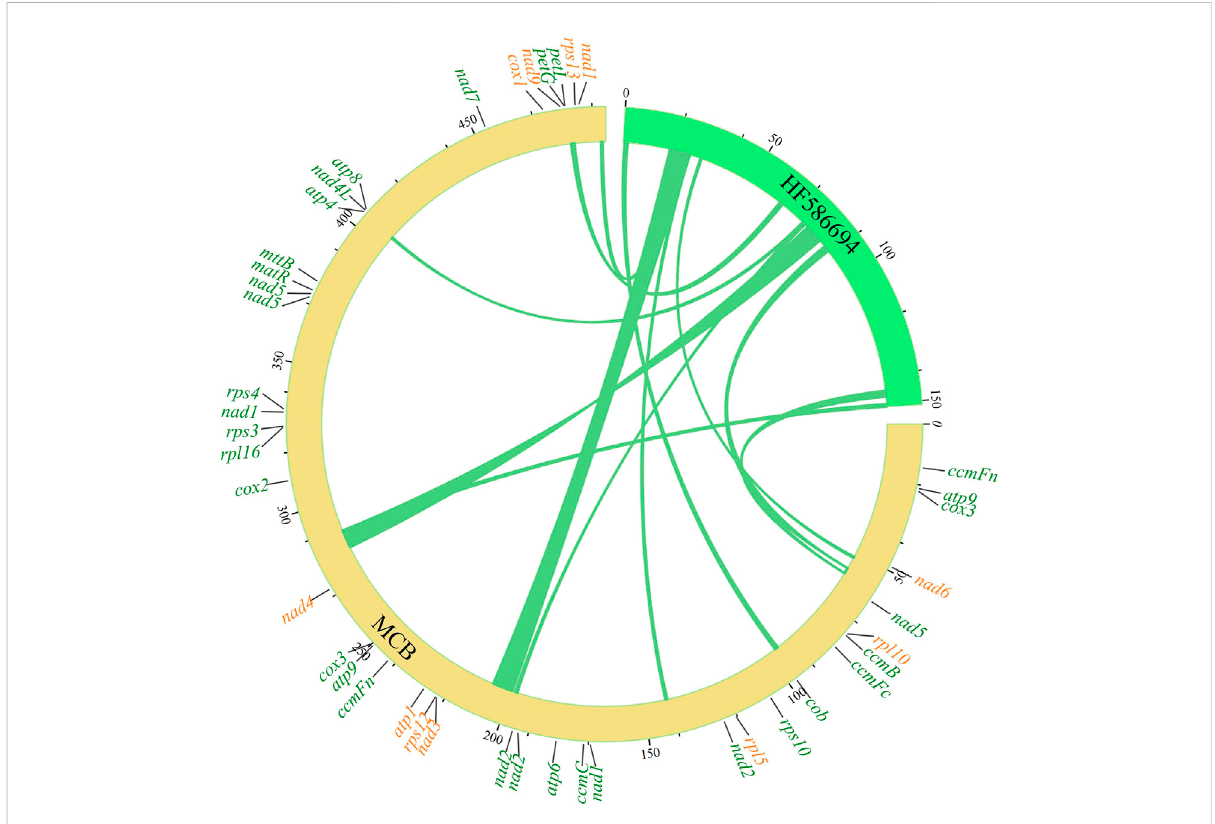
FIGURE 2 Gene transfer between the mitogenome and chloroplast genome of